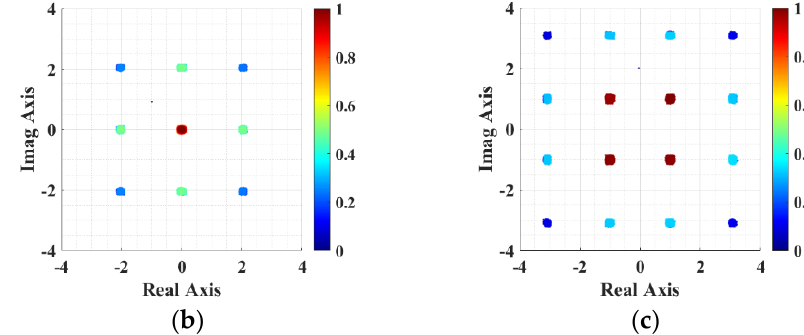
Figure 2. The PDF of n-level polybinary transformation for QPSK signal: ( a ) 1-level polybinary transformation of original signal; ( b ) duobinary transformation; ( c ) tribinary transformation.